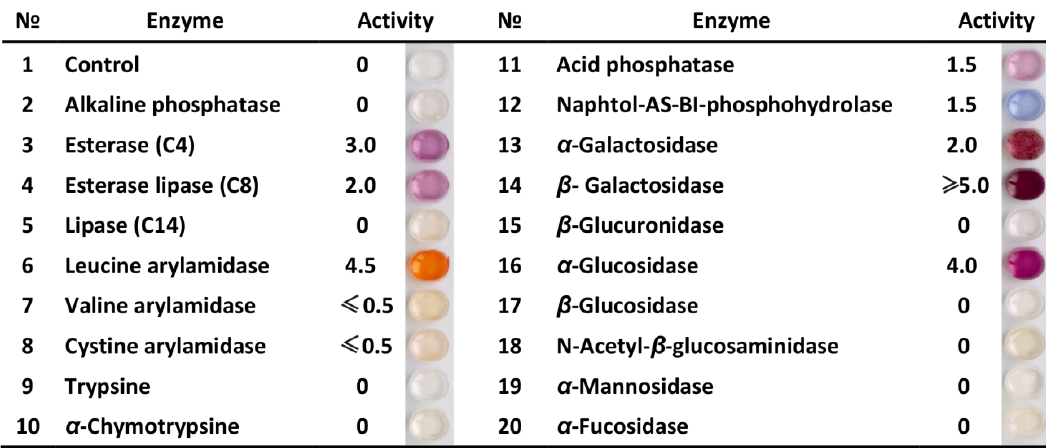
Figure 1. API ZYM enzymatic profile of B. longum MC-42.